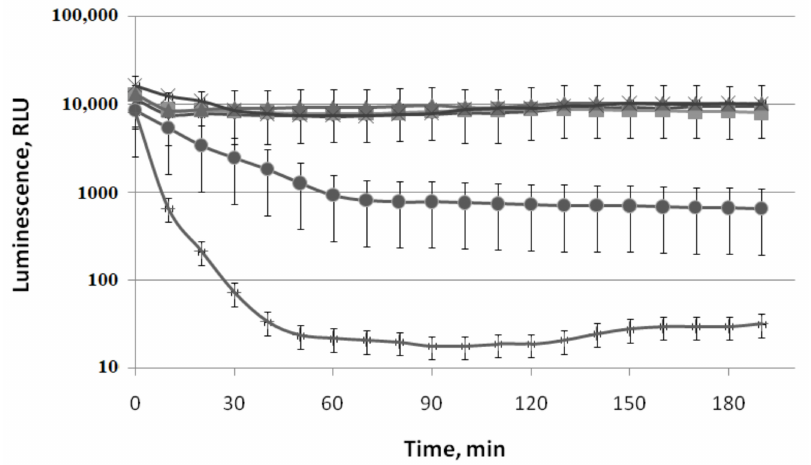
Figure 2. Luminescent response of strain E. coli MG1655 (pKatG’::lux) to hydrogen peroxide ( A ), ( − )-limonene ( B ), and (+)- α -pinene (C). Time course of mean values of light emission (in RLU) in the presence of different chemical concentrations ( A , B ): ( ) 0 µM (black diamond—Control), ( ) 1 Figure 8. Effect of ( − )-limonene and (+)- α -pinene on luciferaseenzymatic activity of P. luminescens µM (gray square), ( ) 5 µM (dark triangle), (×) 25 µM (black cross), (  ) 50 µM (gray asterisk), and in the E. coli MG1655 (pXen7) strain. Kinetics of changes in mean values of light emission (in RLU) at various chemical concentrations: ( ( ) 100 µM (light circle); (C): ( ) 0 µM (black diamond—control), ( ) 5 µM (light square), ( ) 50 µM (gray triangle), ( ) 100 µM (black